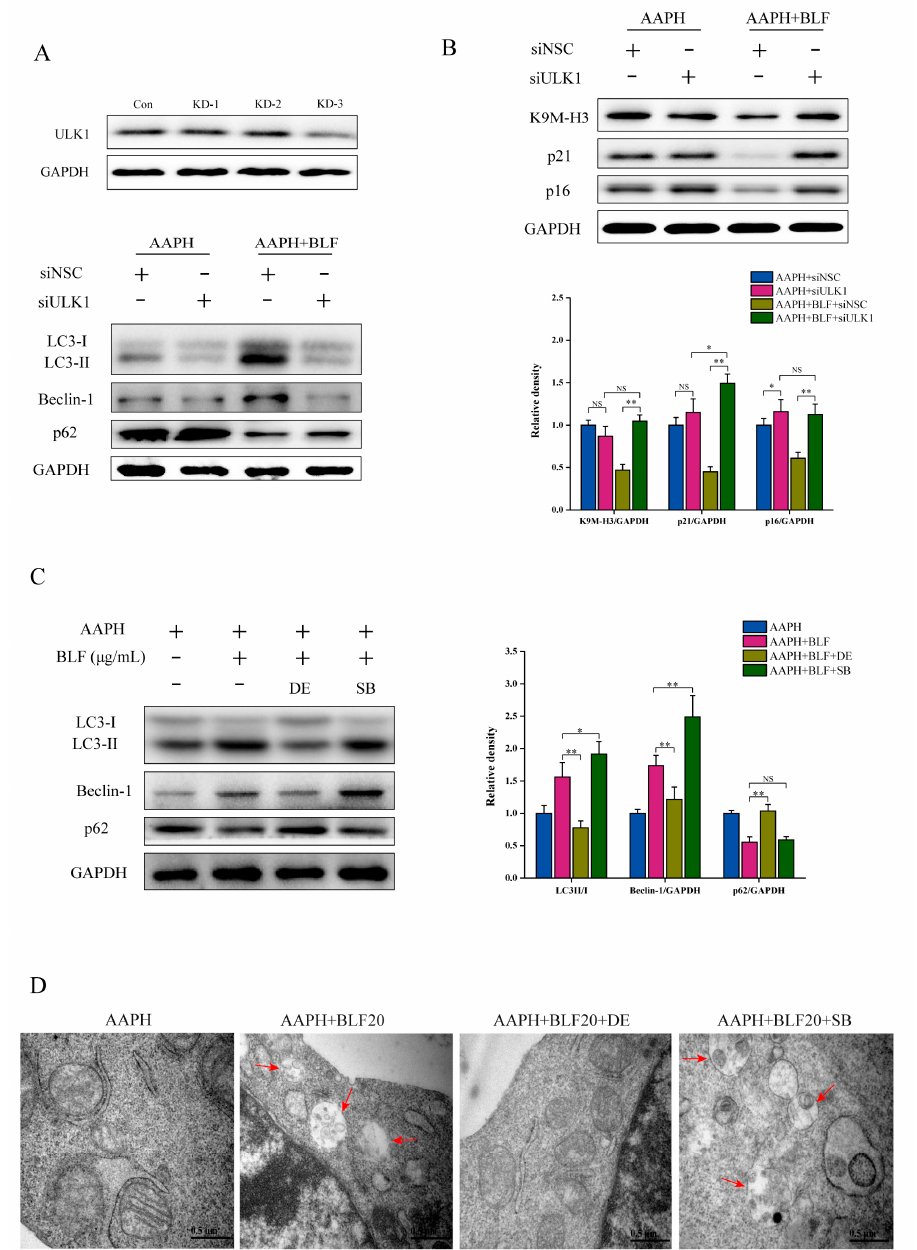
Figure 6. Autophagy participated in the anti-senescence effect of BLF and was regulated by p38 MAPK. ( A ) Silencing efficiency of siRNA targeting ULK1 evaluated by Western blotting. ( B ) Protein expression of p21, p16, and K9M-H3 determined by Western blotting in HaCaT cells transfected with control siRNA or siRNA targeting ULK1. Quantitation is shown below. ( C ) Protein expression of C3-I/II, Beclin-1, and p62 determined by Western blotting after DE and SB treatment in HaCaT cells. ( left ). Quantitation is shown on the right. * p < 0.05, ** p < 0.01. NS, no significant difference. ( D ) Autophagosomes detected by TEM after DE and SB treatment in HaCaT cells. Representative images are shown. Scale bar = 0.5 µ